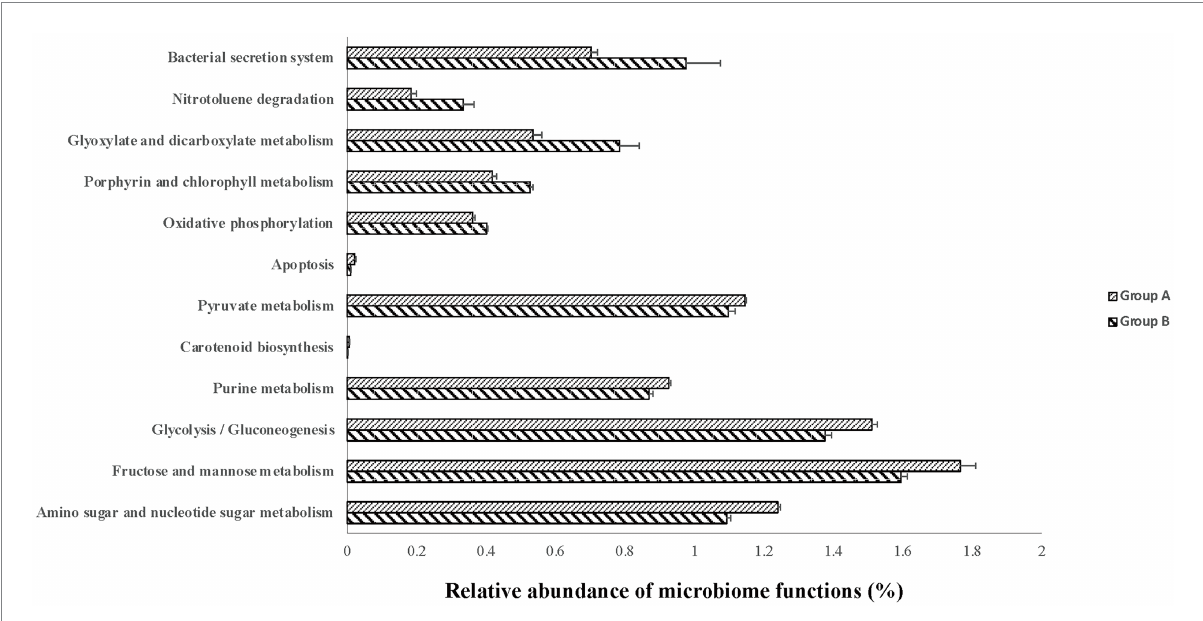
FIGURE 4 The relative abundance of varied second level Kyoto Encyclopedia of Genes and Genomes (KEGG) functions between calves with two type of colon metagenomes. Group A include five animals from the TRT12h treatment based on the principal component analysis plot (Figure 3) clearly separated from the other four animals in TRT12h treatment (group